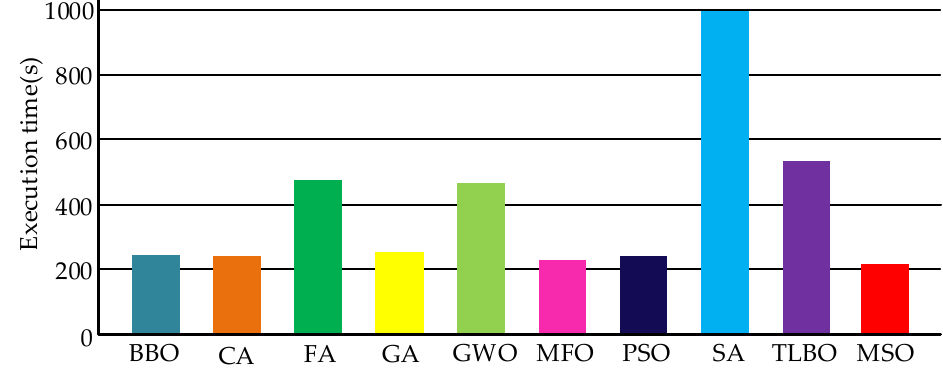
Figure 12. Average execution time obtained by ten algorithms in 10 runs.